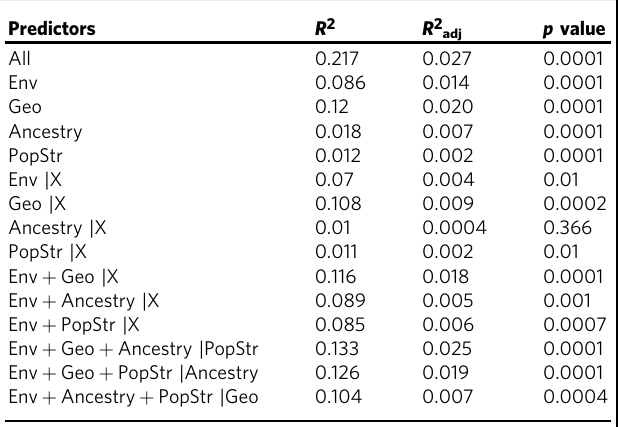
Table 1 Variance partitioning, model R 2 and signi fi cance of multivariate models fi tted using redundancy analyses